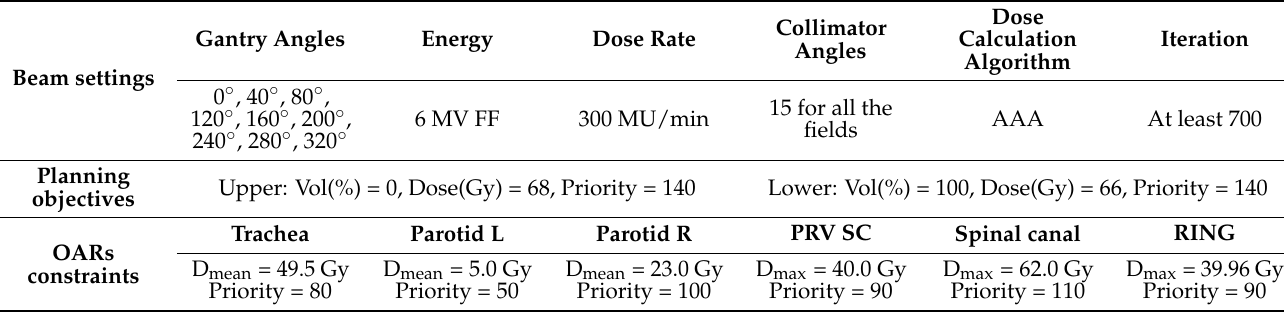
Table 1. Details of the IMRT protocol used to study the stability of the features when derived from almost equivalent plans: beam setup, dose prescription and constraints for organs at risk.